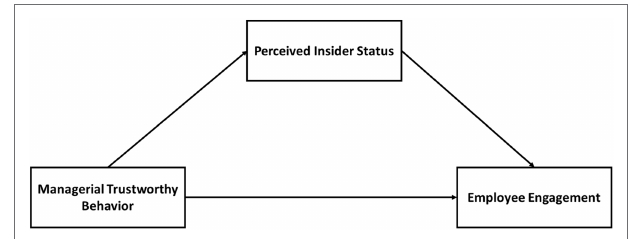
FIGURE 1 | Theoretical